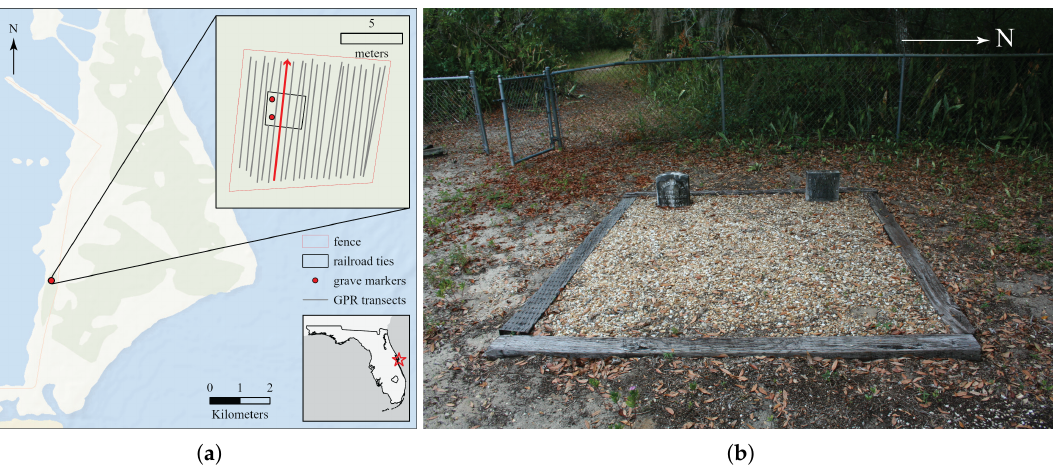
Figure 1. ( a ): Site map showing the location of the Wilson Brothers Cemetery at Cape Canaveral Air Force Station, Florida, U.S. selected for our analysis. GPR transects (inset) crossed perpendicularly over the grave plots. The GPR profile indicated in bold red is shown in Figure 2. ( b ): Photo of the Wilson Brothers Cemetery looking west. Two east-facing headstones are enclosed by partially-buried railroad ties. ( a ) Site Location. ( b ) Site Photo, view to the